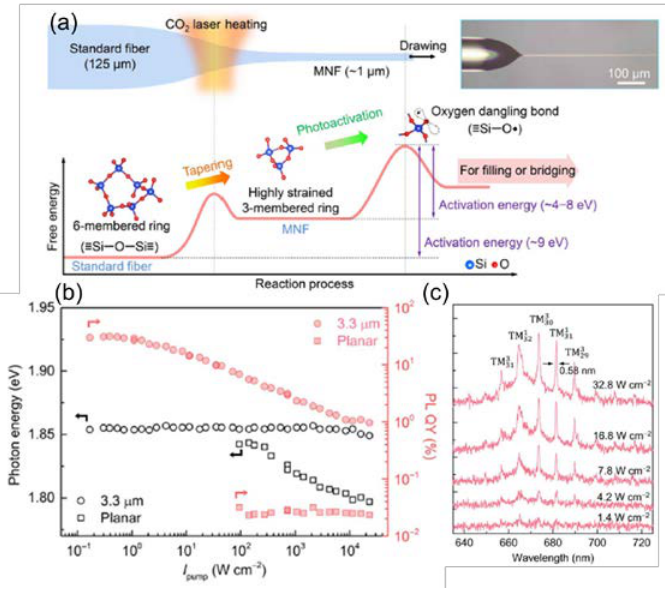
Fig.1 (a) Schematic illustration of generation of oxygen dangling bands from a tapered fiber. The tapering process greatly lowers the activation energy from ≡ Si ─ O ─ Si ≡ to ≡ Si ─ O·. Inset: Optical image of a MNF tapered from a standard fiber. (b) Pump-dependent peak positions (black data) and PL QYs (red data) in the as-photoactivated monolayer MoS 2 (solid circles). A planar sample is also provided for reference (open squares). (c) Steady-state PL spectra in an as-photoactivated MoS 2 monolayer/microbottle (outer diameter,5.5 mm) with increasing I pump , in which WGM oscillations are